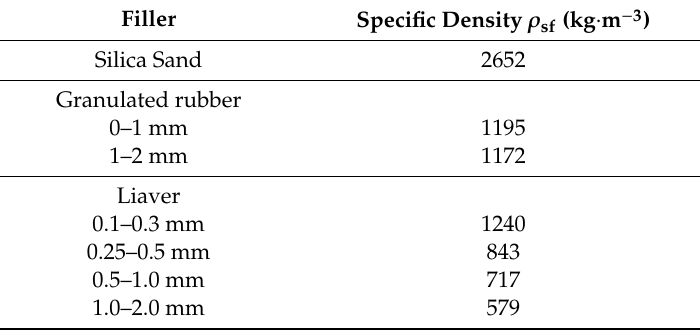
Table 2. The specific density of applied